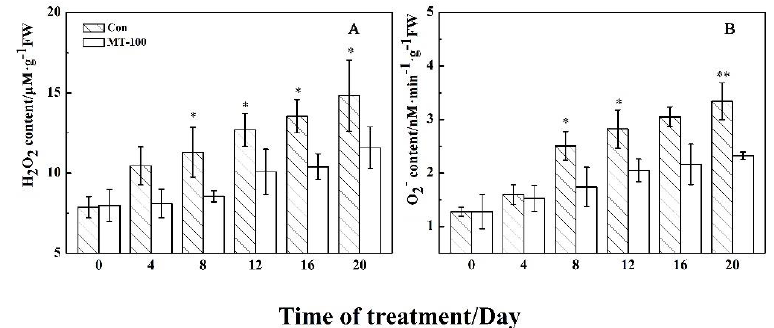
Figure 3. E ff ects of MT on accumulation of H 2 O 2 ( A ) and O 2 − ( B ) in detached grapevine leaves during Figure 3. Effects of MT on accumulation of H 2 O 2 ( A ) and O 2− ( B ) in detached grapevine leaves during dark-induced senescence. ** and * indicate significant di ff erences at 0.01 and 0.05 levels, respectively. dark-induced senescence. ** and * indicate significant differences at 0.01 and 0.05 levels, respectively.